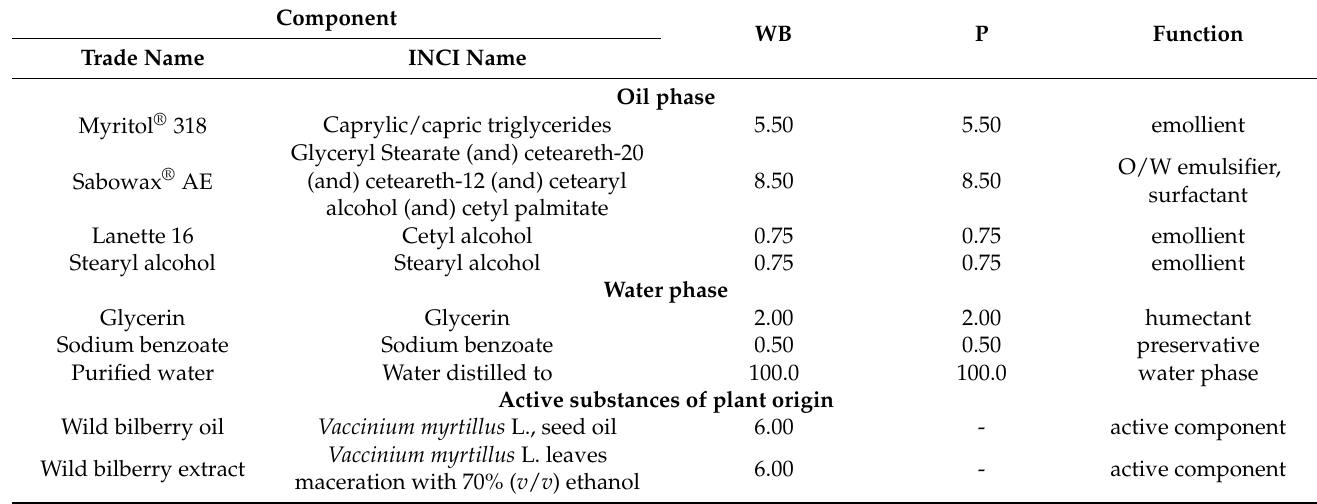
Table 1. Qualitative and quantitative composition (%, ( w / w )) of cream samples: active sample (WB) and placebo